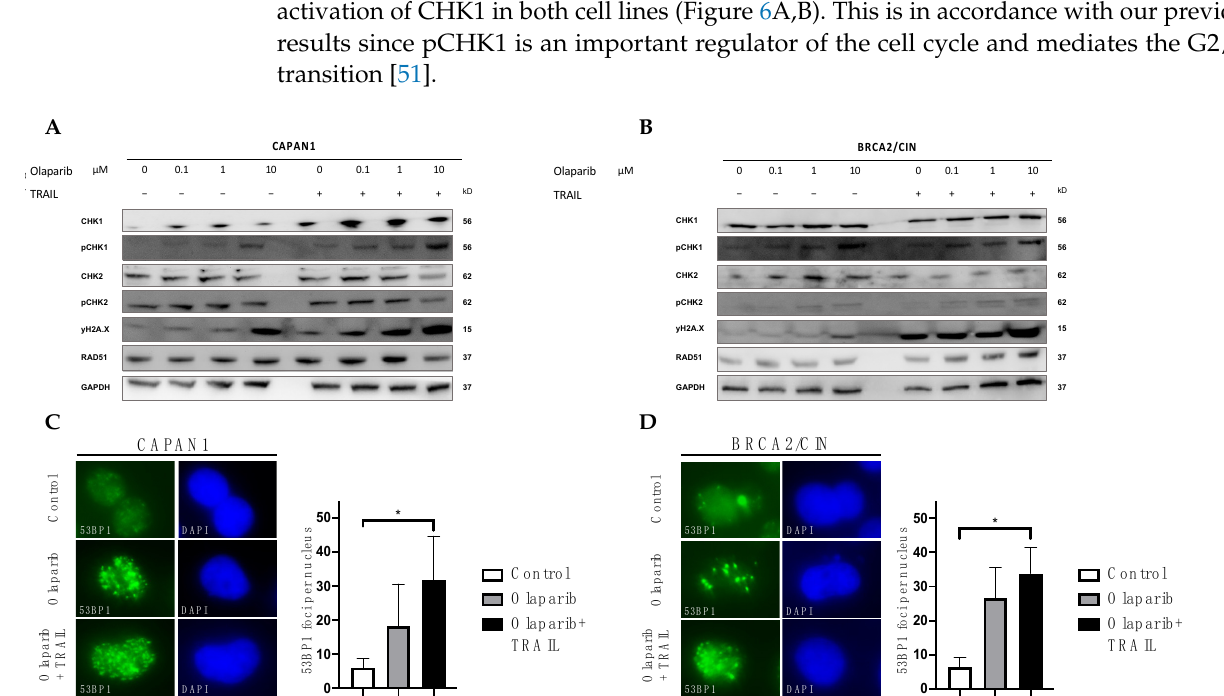
Figure 6. Influence of Olaparib and TRAIL on DNA damage repair. ( A , B ): Western blot anal- ysis to assess the expression levels of the indicated DNA damage proteins in BRCA2 -deficient CAPAN1 vs. wild-type BRCA2 expressing BRCA2/CIN treated with various doses of olaparib alone or in combination with TRAIL for 48 h. Data show representative results from three ex- periments. GAPDH served as a loading control. ( C , D ): 53BP1 immunostaining of BRCA2 deficient CAPAN1 vs. wild-type BRCA2 expressing BRCA2/CIN treated with 10 µ M olaparib +/ − 10 ng/mL TRAIL or dimethyl sulfoxide (DMSO) control for 48 h. Quantification of 53BP1 foci per nucleus was based on at least 10 nuclei per sample. Error bars represent mean ± SD. * = statistical significance, p <